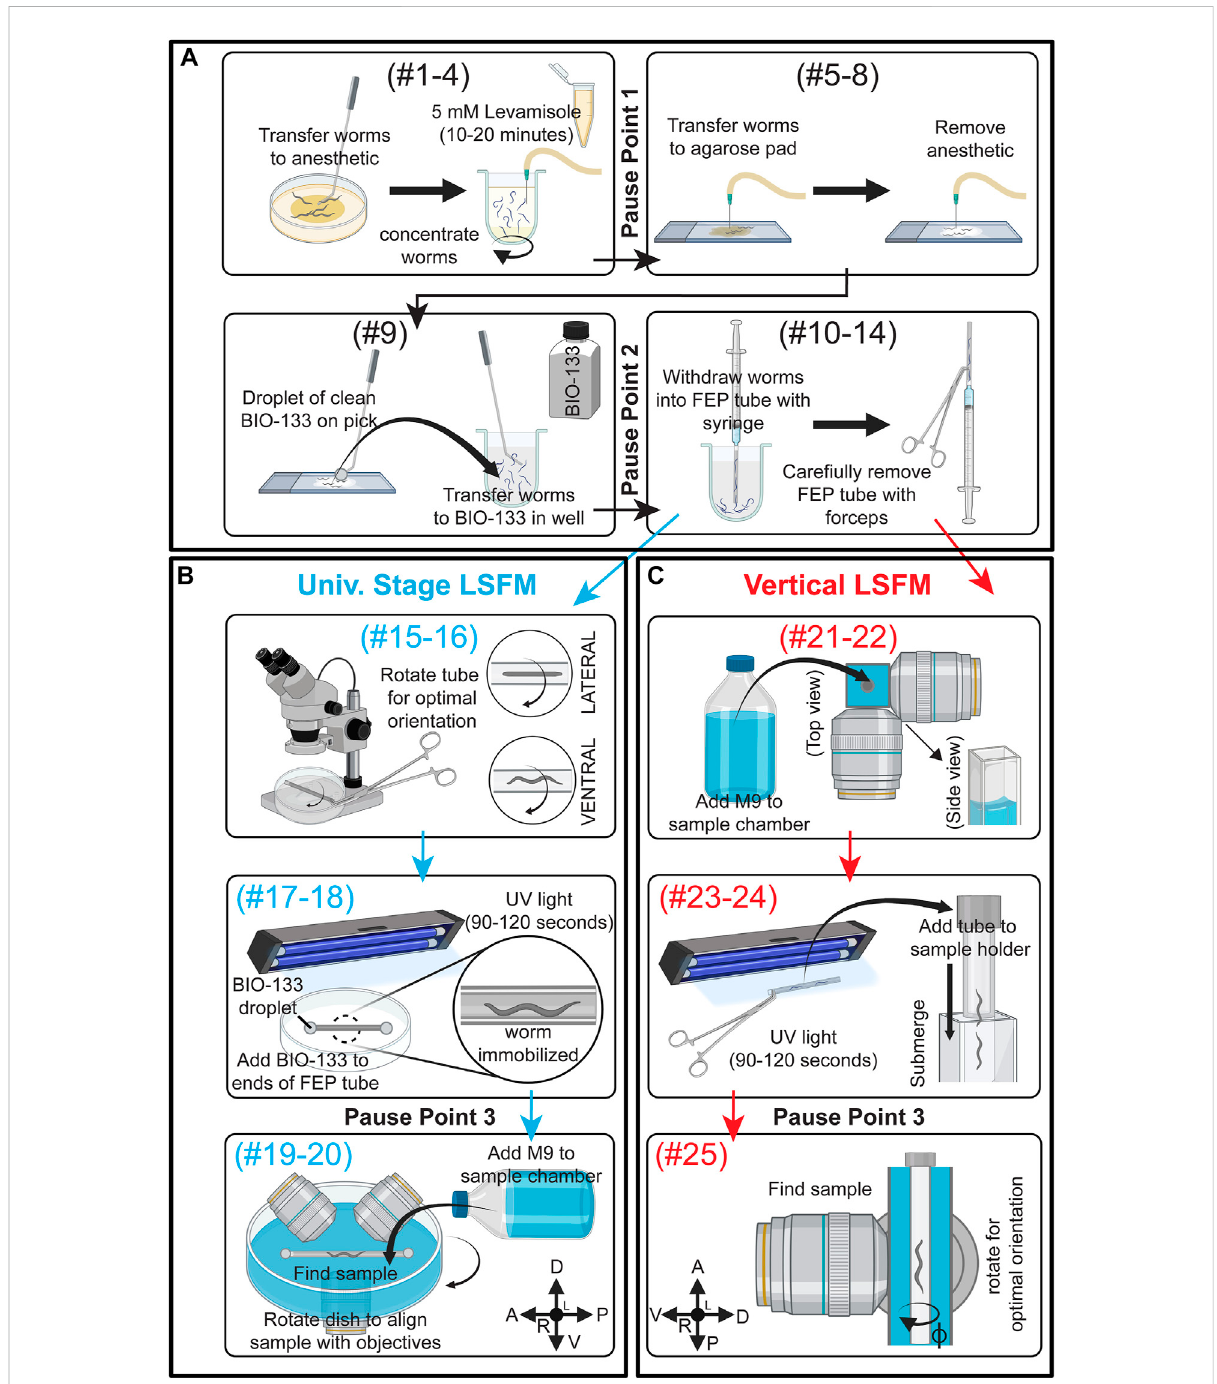
FIGURE 1 Schematicsummaryof C.elegans post-embryonicBIO-133mountingstrategiesforLSFMimaging. (A) Aschematicsummaryofsteps#1 – 14of the FEP-BIO-133 mounting protocol for time-lapse imaging of post-embryonic C. elegans on light sheet fl uorescence microscopes, including animal anesthesia (top left, steps #1 – 4 ), transfer to BIO-133 (top right, steps #5 – 8 ), BIO-133 encapsulation (bottom left, step #9 ), and sample withdrawal into the FEP tube (bottom right, steps #10 – 14 ). Protocol steps #1 – 14 can be used for mounting samples on LSFMs con fi gured with either a universal stage mount or a vertically-mounted sample. Pause points #1-2 in the procedure are indicated where they occur in the protocol. (B) A schematic summary of FEP tube-sample orientation (top, steps #15 – 16 ), UV-curation and bonding of FEP tube to Petri dish sample imaging chamber(middle, steps#17 – 18 )and samplemounting(bottom, Steps#19 – 20 )forLSFM systemsequippedwith auniversalstagemount.After steps #1 – 14 (A) , proceed to steps #15 – 20. Pause point #3 is indicated. (C) A schematic depicting preparation for a vertically-mounted sample, including sample chamber fl ooding (top, steps #21 – 22 ), UV-curation and loading of the FEP tube into the sample holder (middle, steps #23 – 24 ) and